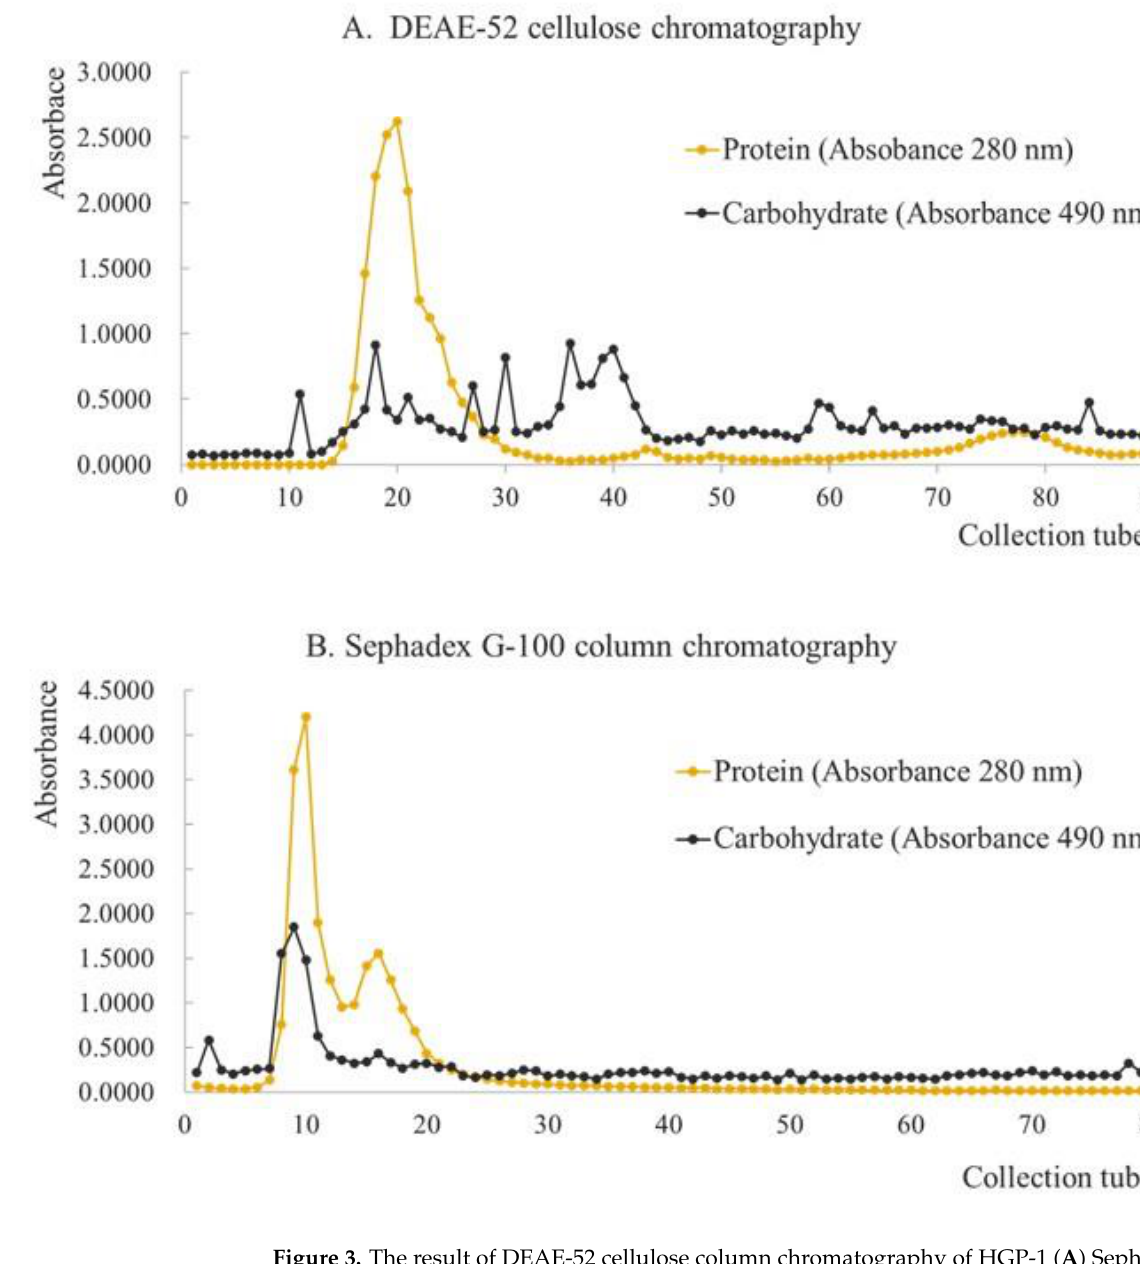
Figure 3. The result of DEAE-52 cellulose column chromatography of HGP-1 ( A ) Sephadex G-100 column chromatography of HGP-2 ( B ).